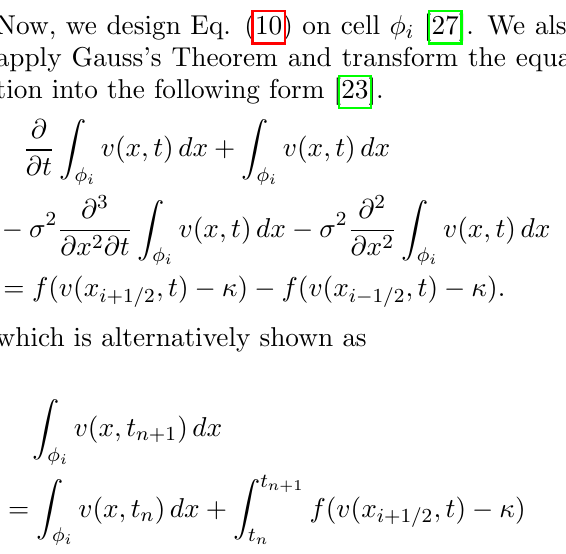
Figure 3. The discretised domain in 1D with L = 1 and N x =